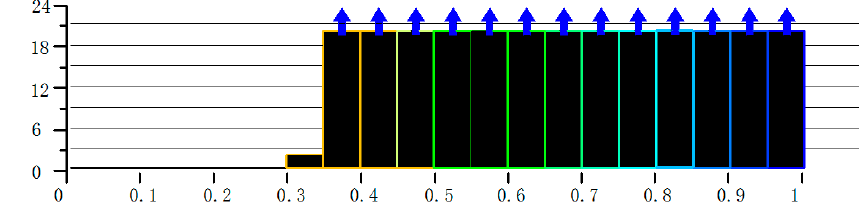
Figure 8. The mesh quality of cyclone.